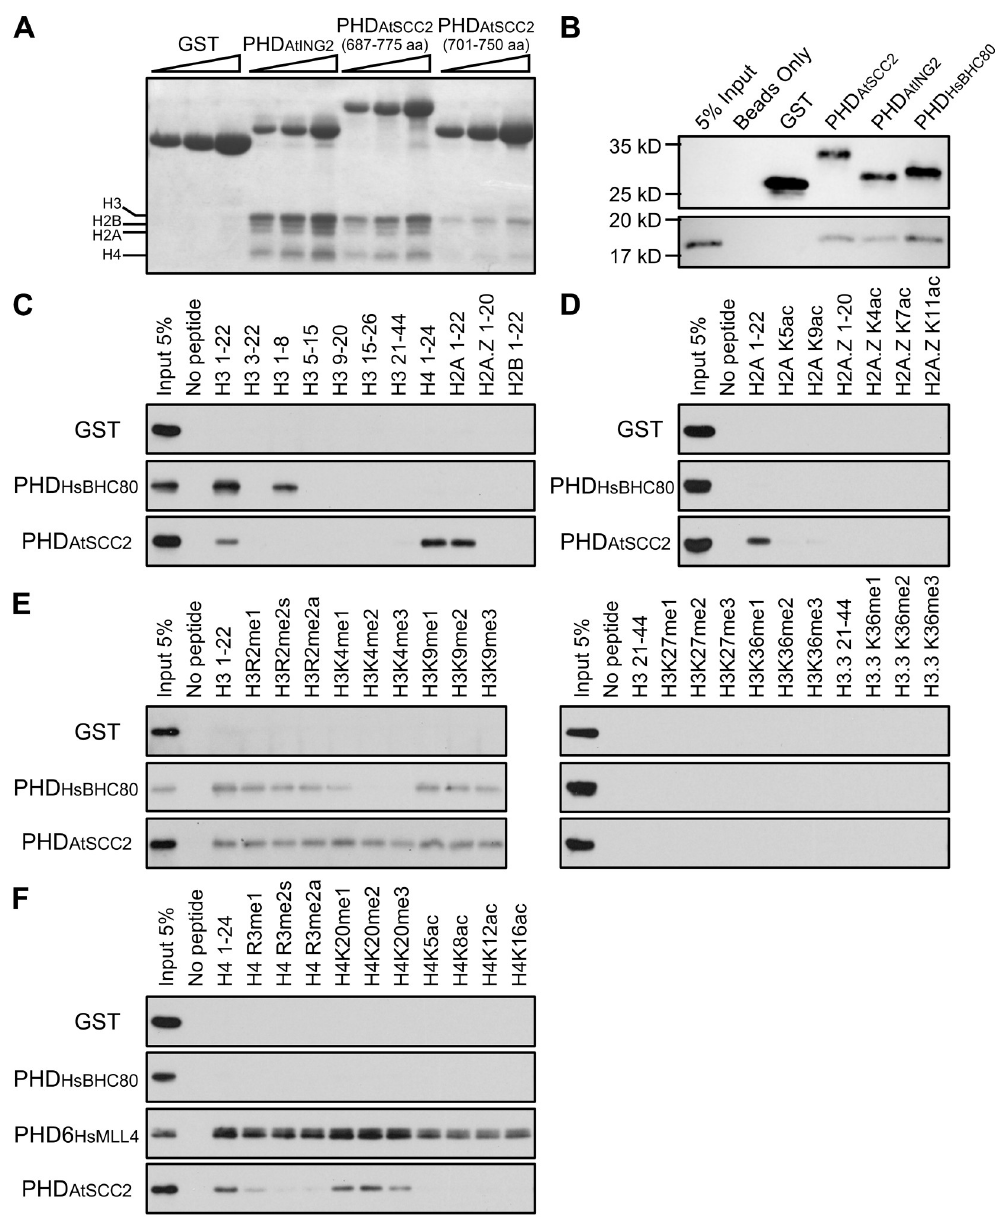
Fig 7. AtSCC2 PHD can bind to histones. (A) Pull-down assay of GST, GST-AtING2 PHD , GST-AtSCC2 PHD (687–775 aa) , GST-AtSCC2 PHD (701–750 aa) with calf thymus histones. (B) Pull-down assay of GST, GST-HsBHC80 PHD , GST- AtSCC2 PHD (687–775 aa) with H3. (C) Pull-down assay of GST, GST-HsBHC80 PHD , GST-AtSCC2 PHD (687–775 aa) with different histone peptides in N terminal length. (D) Pull-down assay of GST, GST-HsBHC80 PHD , GST-AtSCC2 PHD (687–775 aa) with unmodified and modified H2A peptides. (E) Pull-down assay of GST, GST-HsBHC80 PHD , GST-AtSCC2 PHD (687–775 aa) with unmodified and modified H3 peptides. (F) Pull-down assay of GST, GST-HsBHC80 PHD , GST-AtSCC2 PHD (687–775 aa) with unmodified and modified H4